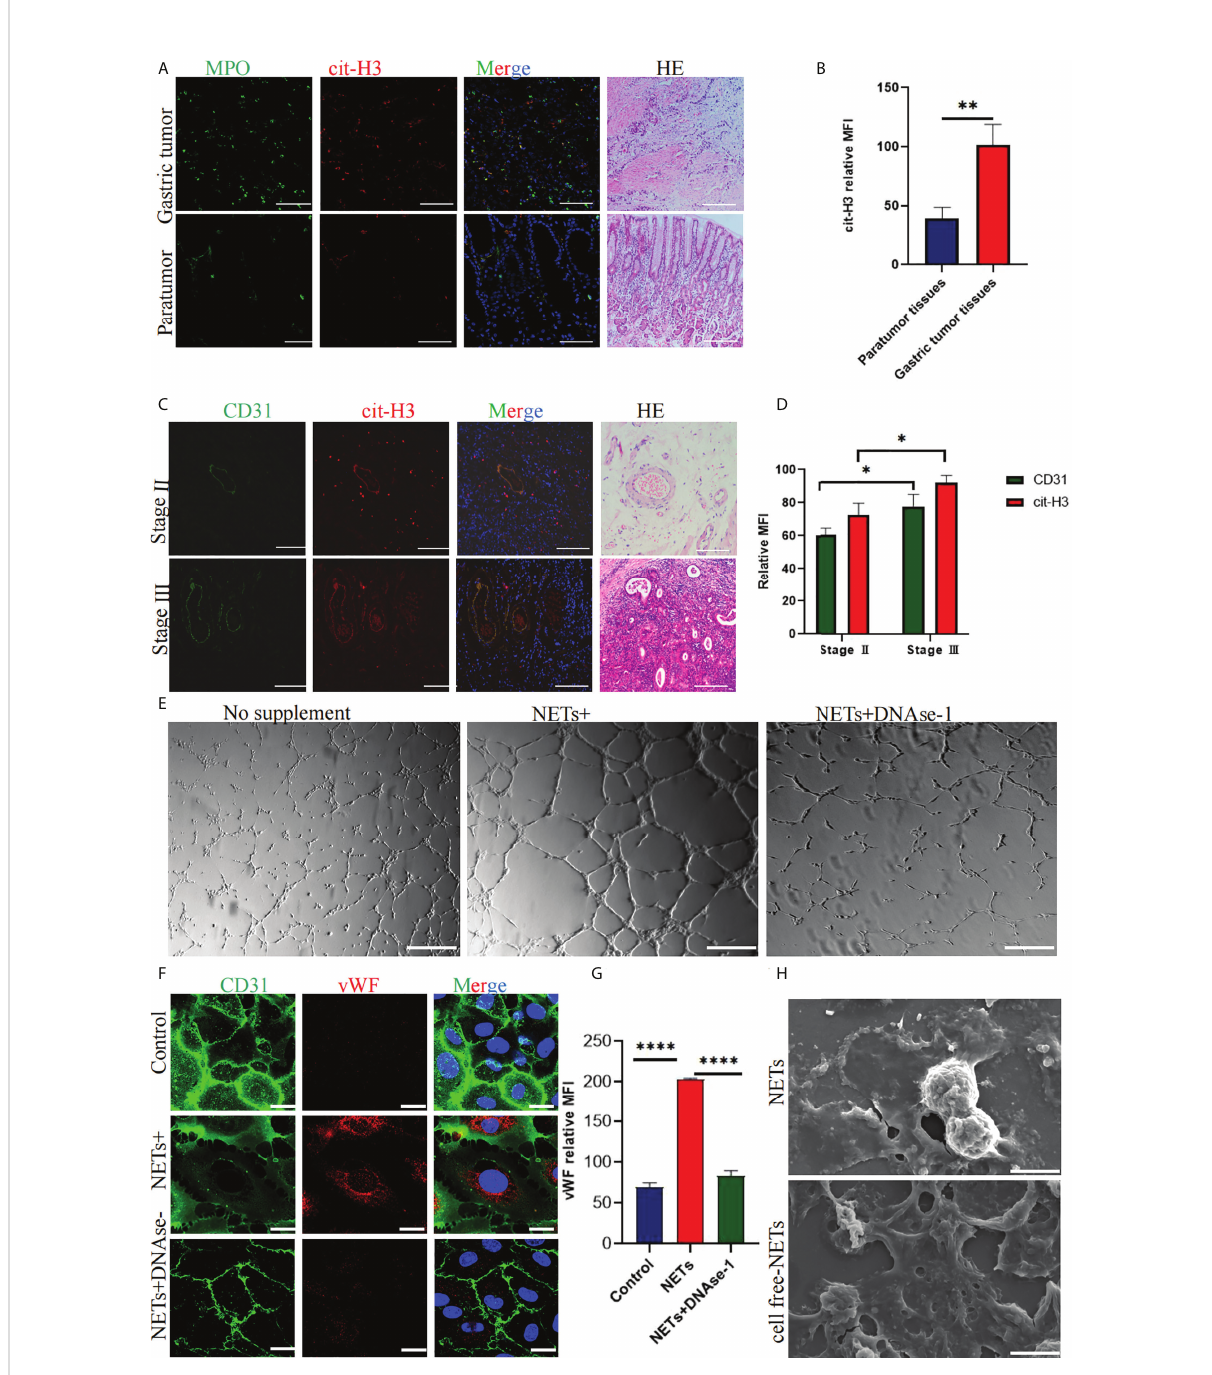
FIGURE 1 Expression of NETs in gastric cancer (GC) and paracancerous tissues and quanti fi cation of related factors in NET-stimulated HUVECs. (A) NETs deposition in GC and paracancerous tissues was analyzed by immunohistochemical staining. HE staining was used to analyze the distribution of microvessels in GC and paracancerous tissues. (B) Quantitative analysis of cit-H3 in GC and paracancerous tissues. (C) The localization of CD31 and NETs marker cit-H3 in GC. HE staining was used to analyze the distribution of microvessels in different stages of GC. (D) Mean fl uorescence intensity of CD31 and cit-H3 in tumor tissues at different stages. (E) Tubule formation of HUVECs stimulated with PBS, NETs, and NETs+DNAse- 1 was analyzed by a tube forming experiment. (F, G) The vWF expression on HUVECs was detected by confocal microscopy and analyzed with Image J software [the expression is indicated as the mean fl uorescence intensity (MFI). (H) NETs and cell-free NETs imaged by scanning electron microscope. 20× objective. Scale bars indicate 20 mm. Arrows indicated ETs. All values are mean ± SD. ****P < 0.0001, **P < 0.01, *P < 0.05 by one -way ANOVA or